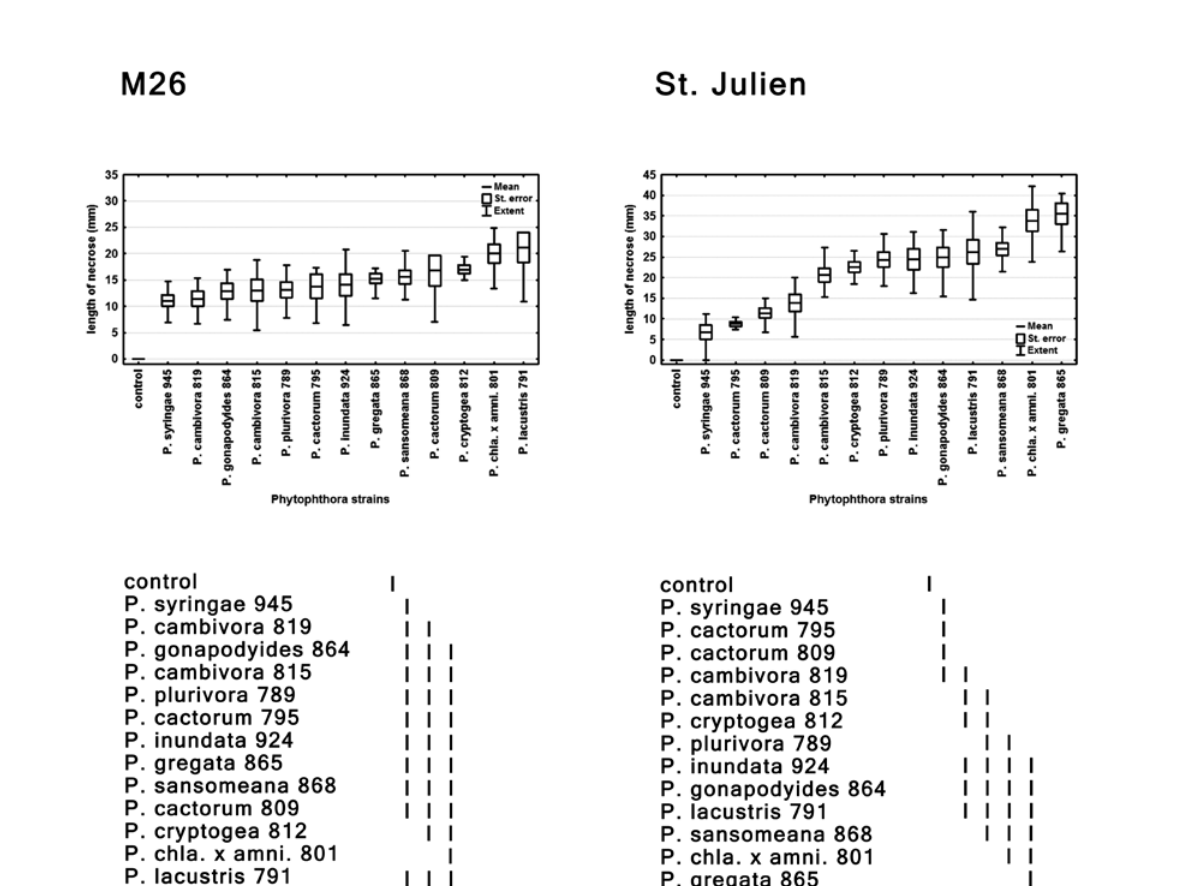
Figure 5. Virulence of Phytophthora isolates in ´M26´ and ´St. Julien´ rootstocks. The means, quartiles, extents and outliers are presented in the graphs and homogeneous groups in the